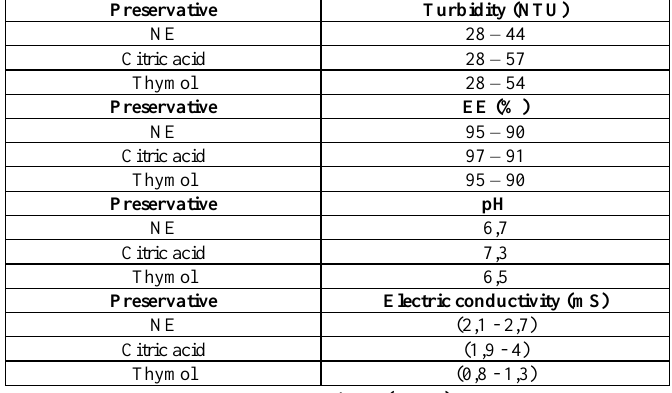
Table 1: Evaluation and preservative